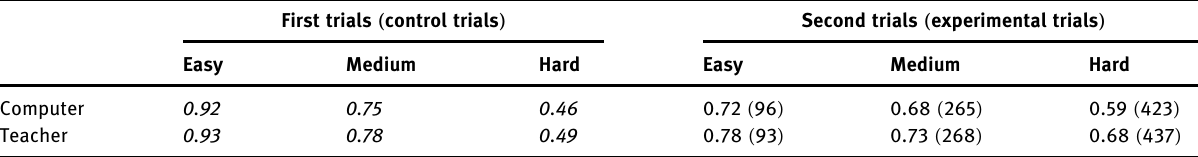
Table 2: Experiment 2. Participants ’ test performance measured via accuracy score as a function of di ffi culty and trial session First trials ( control trials